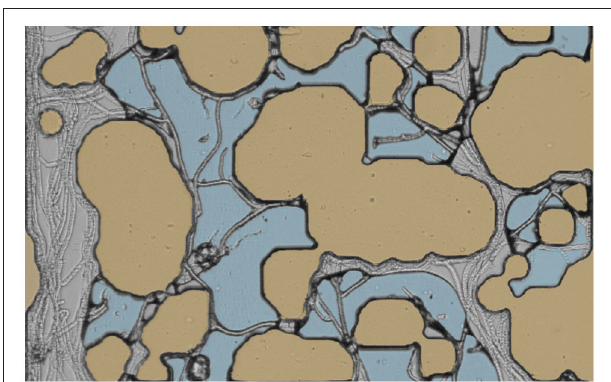
FIGURE 3 | Preferential spread of R. solani in air-filled pores. Flas colors have been added to highlight the different phases. The water is represented in blue, and the solid particles in brown. Hyphae are clearly seen to prefer growing in pores without water, even though some hyphae manage to grow inside the liquid phase. The width of the image corresponds to